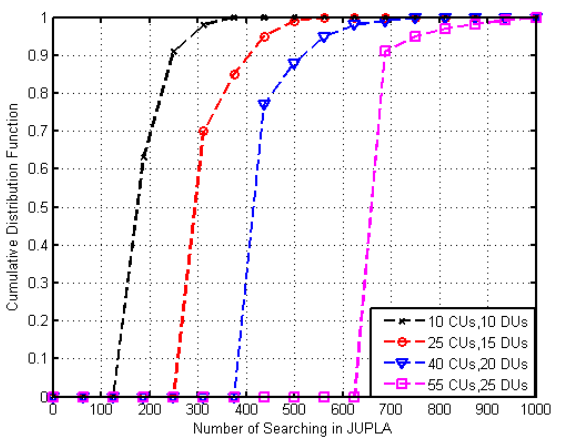
Figure 7. CDF of the number of branches in each search process, with ∆ = 0.15, which depicts the probability of finding out the solution increases with the growing of the search number.